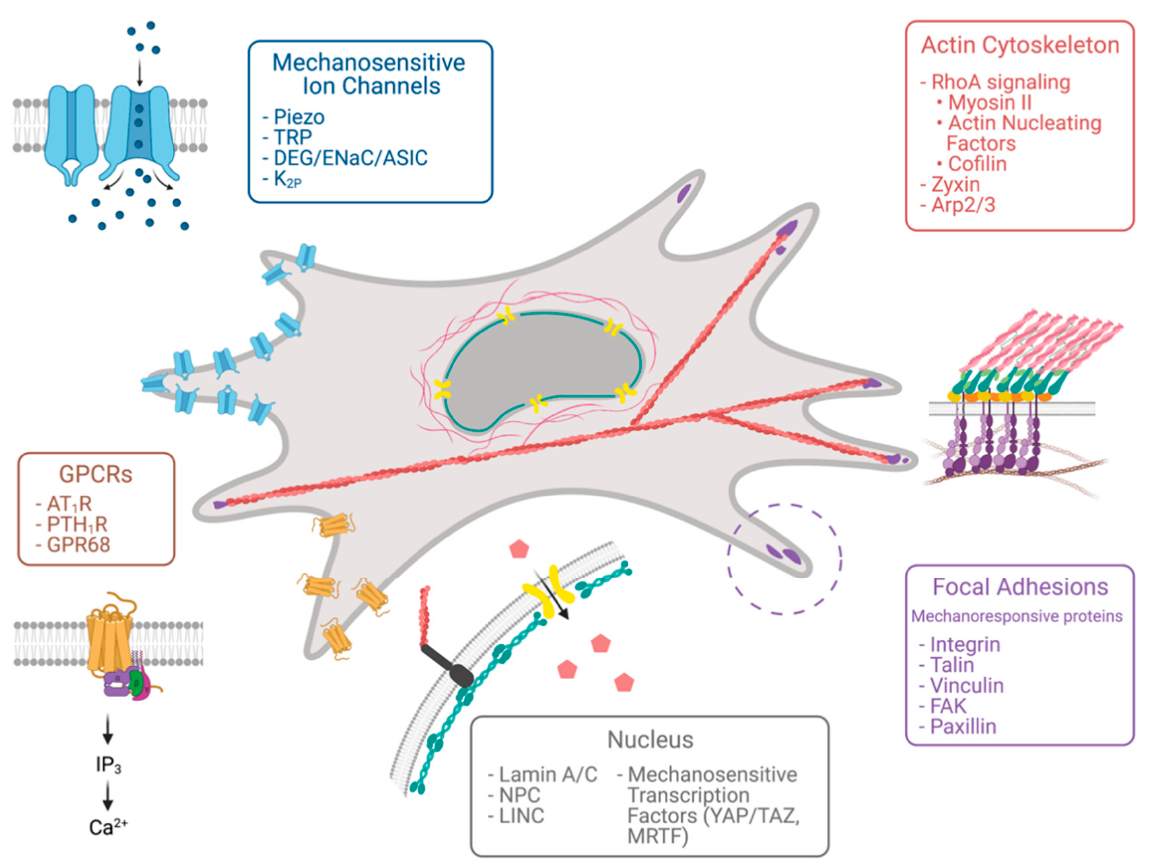
Figure 2. Molecular sensors of tissue stiffness. Various cellular compartments respond to mechanical force, including focal adhesion proteins, the actin cytoskeleton, the nucleus, mechanosensitive ion channels, and G-protein-coupled receptors. Created with BioRender.com.